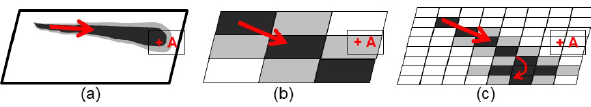
Figure 3. Schematic comparison of surface concentration contours and model grid-cell values of a transported pollutant plume from a large stack (termed a “point” source). Wind direction shown by red arrows. Monitoring station location marked by “ + A”. (a) Ac- tual plume. (b) Coarse grid-cell size air-quality model prediction. (c) Fine grid-cell size air-quality model prediction. Note the change in wind direction between observations (a) and simulations (b, c) associated with errors in the forecast of the synoptic wind.